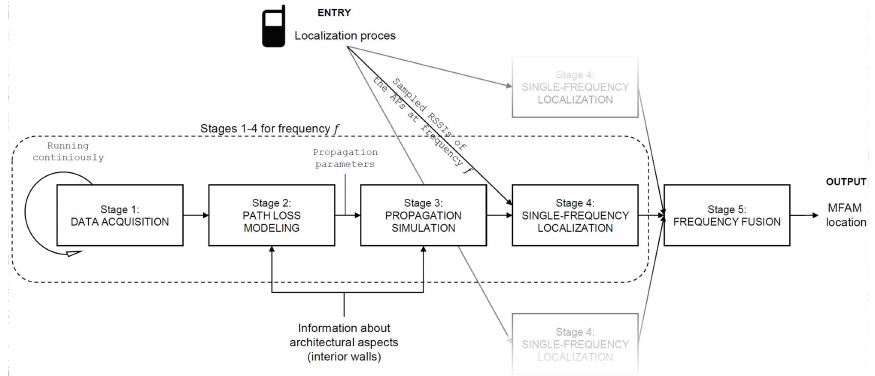
Figure 1. Overview of the method and its five